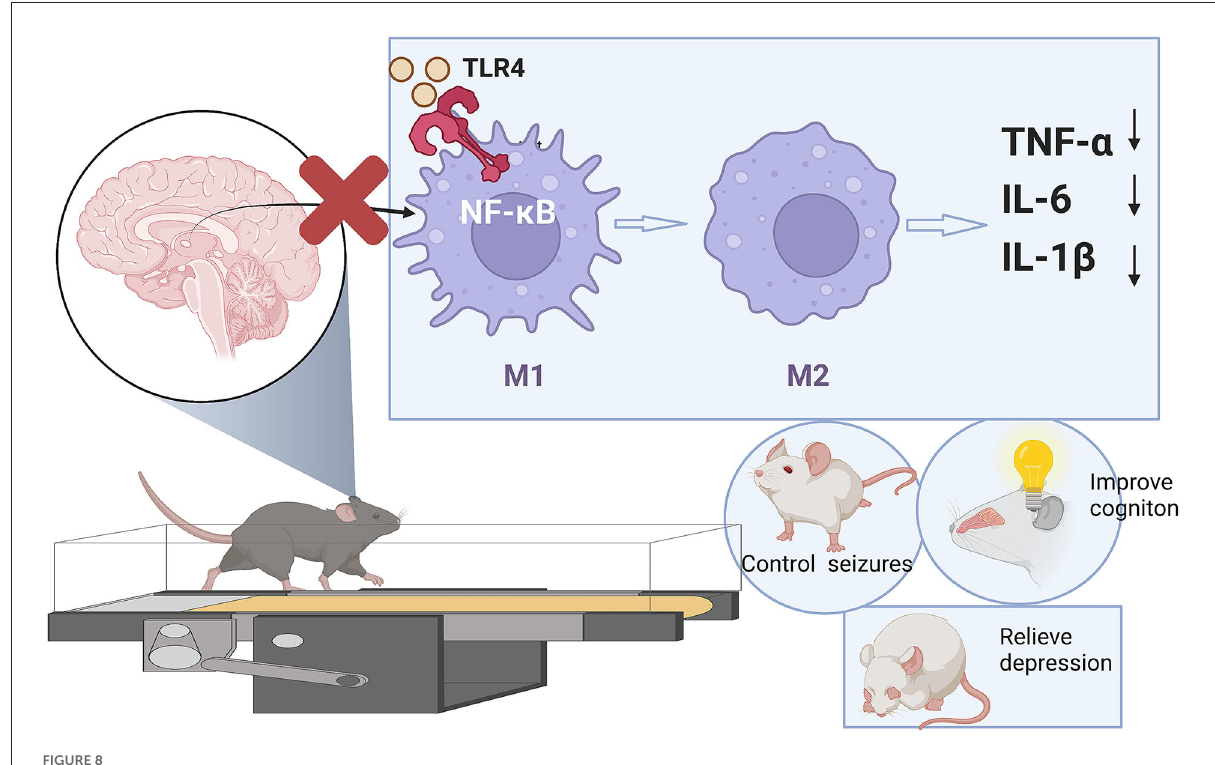
FIGURE8 Summary of the